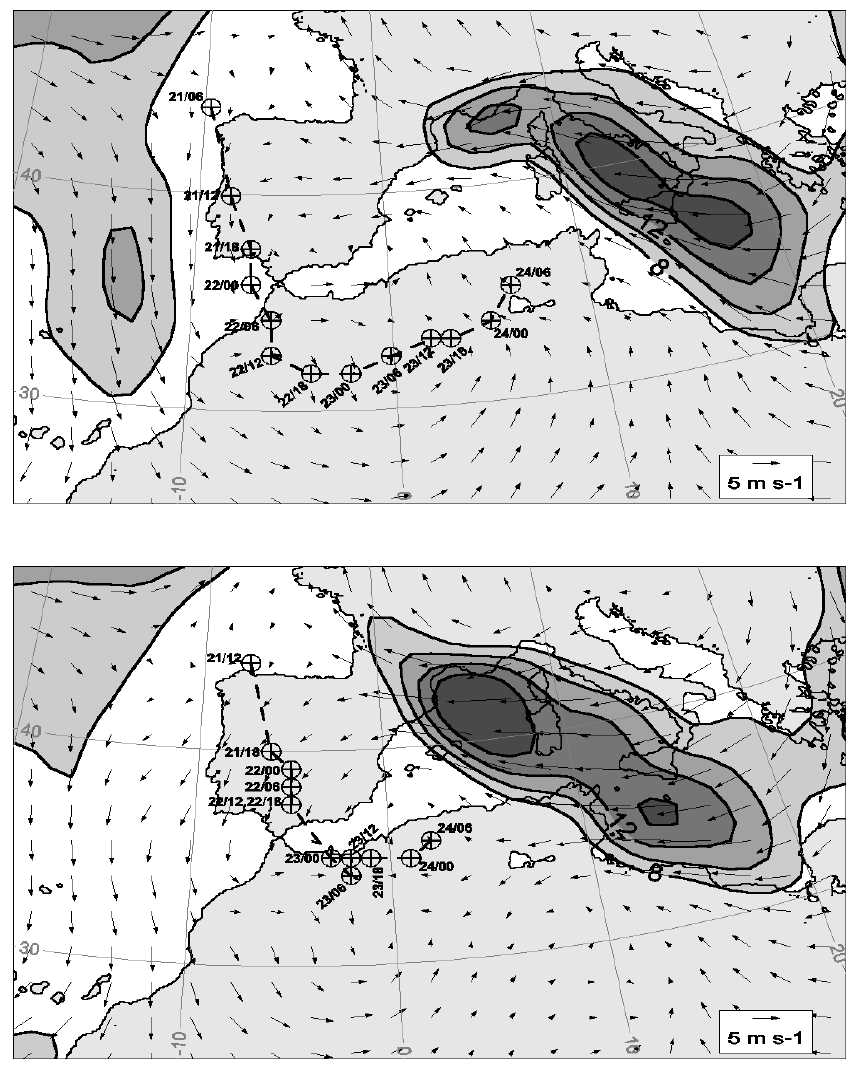
Fig. 23. As in Fig. 8 but for noC exper- iment. Note that the cutoff center loca- tions of 22/12 and 22/18 coincide on the same model